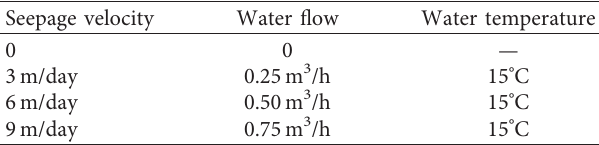
Figure 3: Schematic diagram of temperature measurement point layout (note: the color-filled freezing pipe is in the working state, and the other two freezing pipes are closed). Table 1: Relationship between seepage velocity and water flow in the